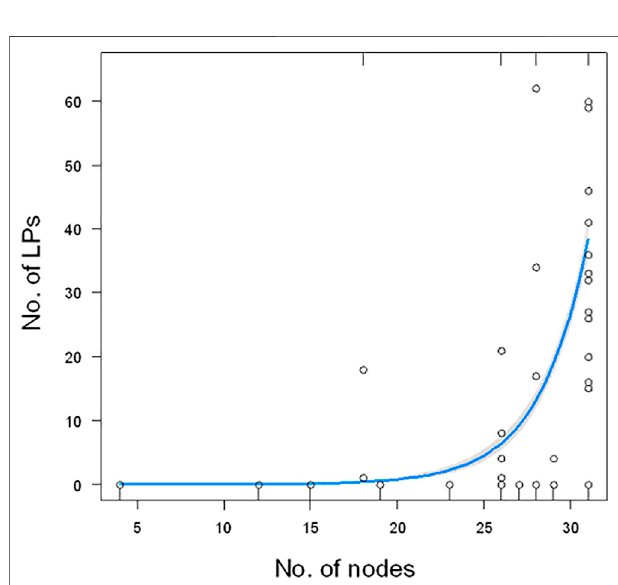
FIGURE 2 | Relationship between the number ofLPs and the number of nodes from the root of the tree. The plot does not show one extreme value (180 for Cupiennius salei ). The blue line show the estimated model (GLM) with 95% con fi dence bands (gray).